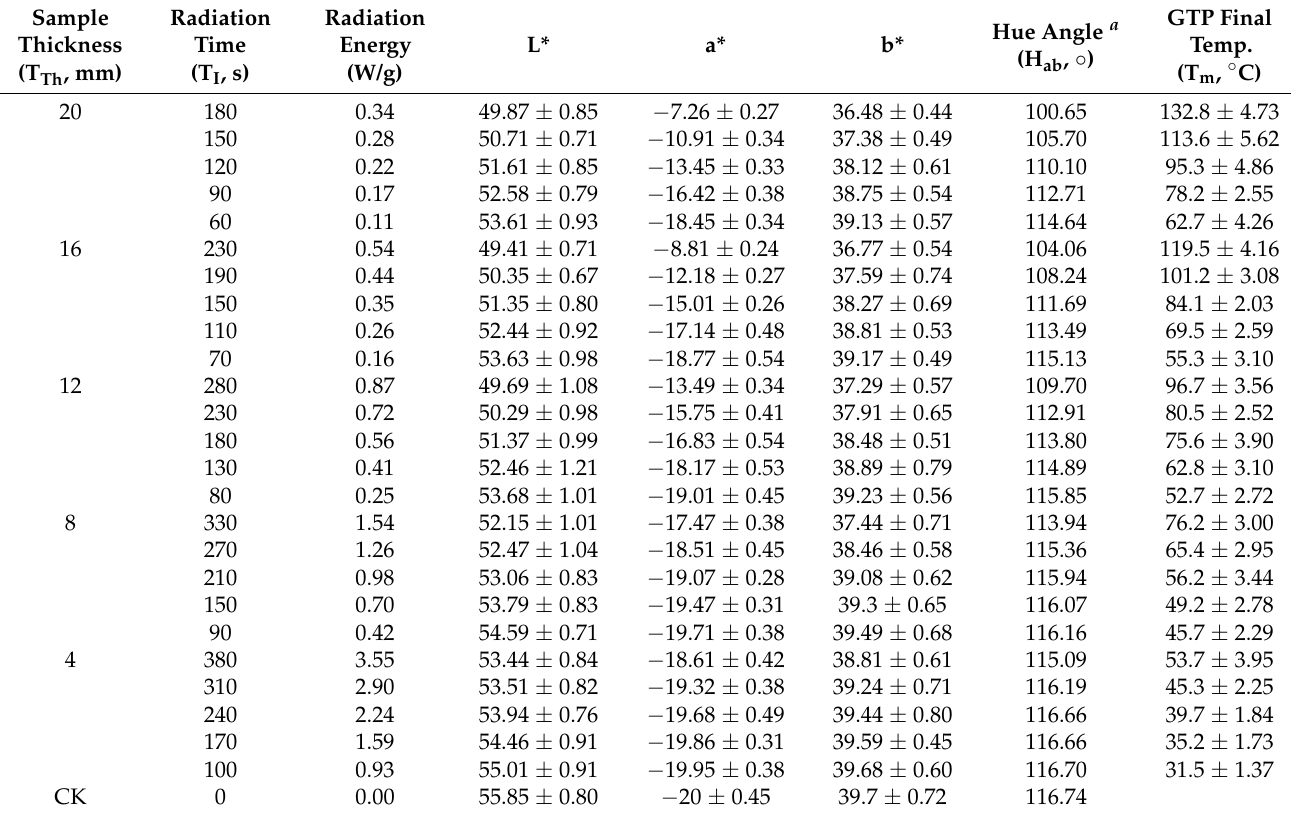
Table 2. Hunter L*, a* and b*, H a and final temperature of green tea powder (GTP) with different thickness radiation with various times under microwave radiation under 700